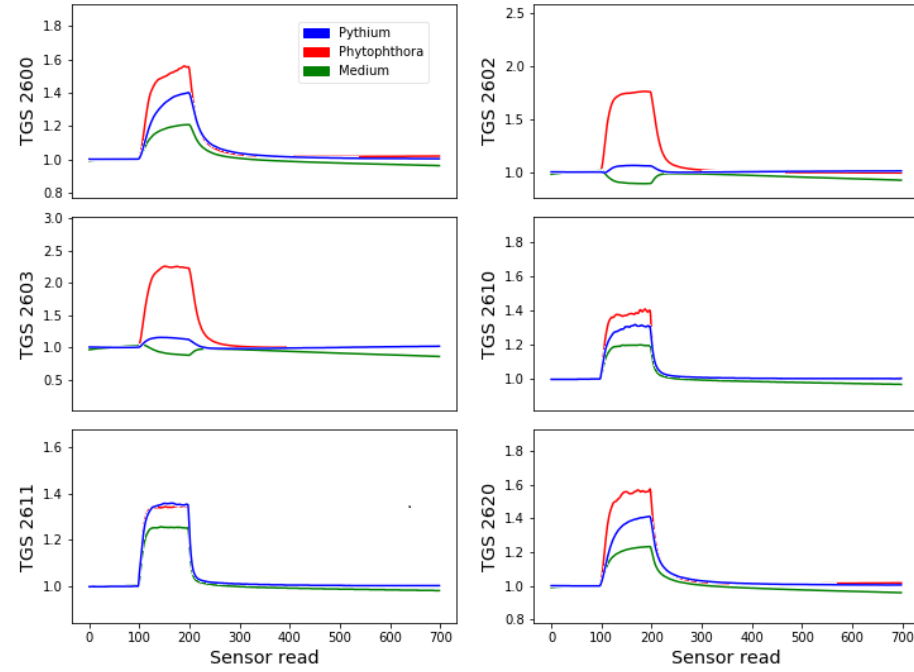
Figure 3. Examples of sensor response versus time of measurement (number of reading during measurement) for each sensor in the sensor array. Separate curves for three studied sample types are presented. Y -axis represents the sensors’ responses normalized by the baseline value, calculated as G / G 0 , where G is the measured conductance, and G 0 is the average of the conductance measured in the clean air. On the X -axis, the numbers of sensor reads are shown, which happens every 1.22